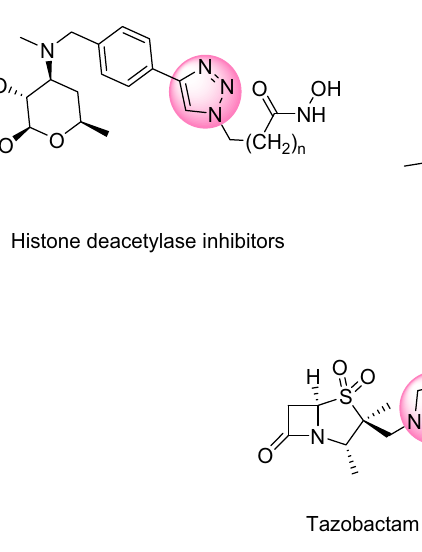
Figure 1. Compounds containing triazole ring with biological and pharmacological